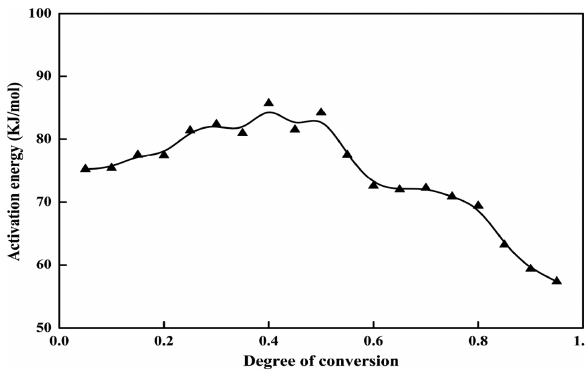
Figure 5: Change of Activation energy of curing at different degree of conversion.